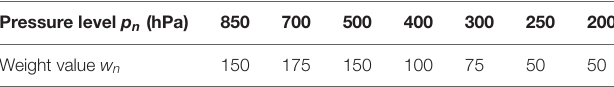
TABLE 2 | The weight for each pressure level.